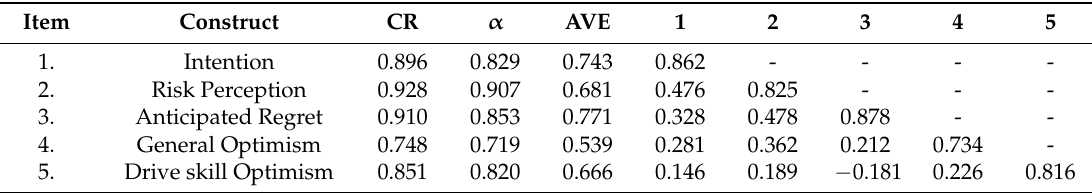
Table 3. Interconstruct correlations.